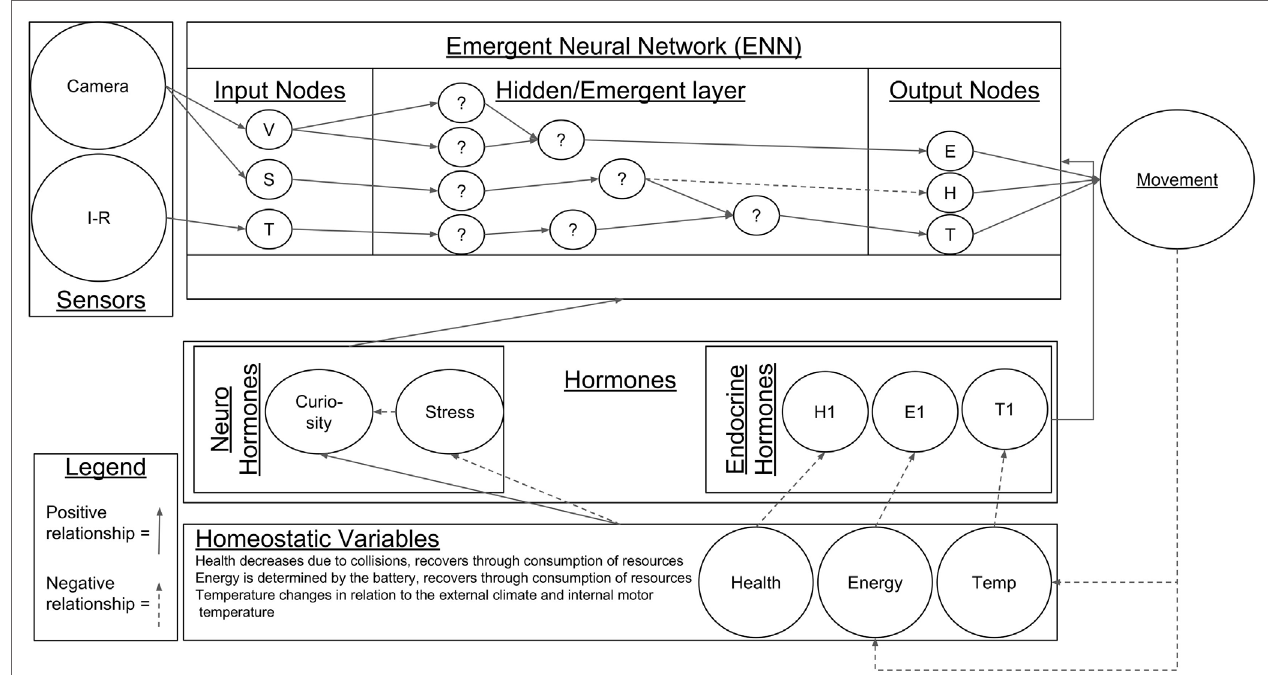
FigUre 1 | The robotic architecture used in this experiment